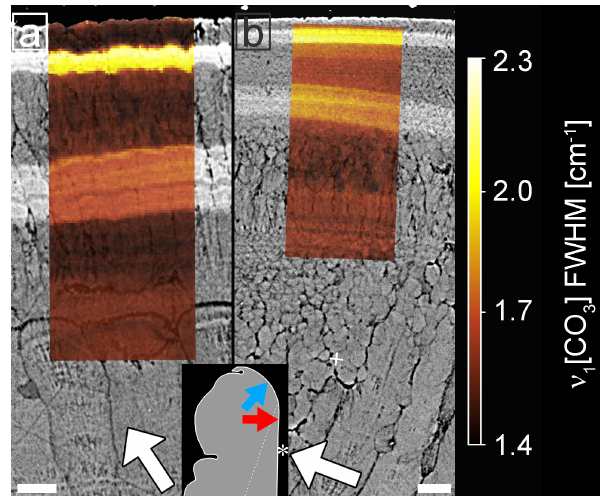
Figure 2. FEG-SEM BSE images showing polished cross sections of the oOSL (a) and iOSL (b) of a Sr-labelled K. rhytiphora shell (specimen ID: K2-06) overlain with NanoSIMS 88 Sr / 40 Ca maps. Shell layers grown in ambient seawater 88 Sr / 40 Ca ratios are de- picted in blue, while shell formed during Sr-enriched incubations are shown in pink. White arrows identify the general growth direc- tion of the shell, while the Sr-labelled shell layers from the under- lying BSE image visualize the local growth directions for each ul- trastructure. A schematic of the shell tip shows the exact location of the NanoSIMS maps with blue and red arrows pointing towards the locations of the prismatic oOSL (a) and crossed-acicular iOSL (b) sampling locations, respectively. Asterisk marks the inner shell sur- face. Scale bars are